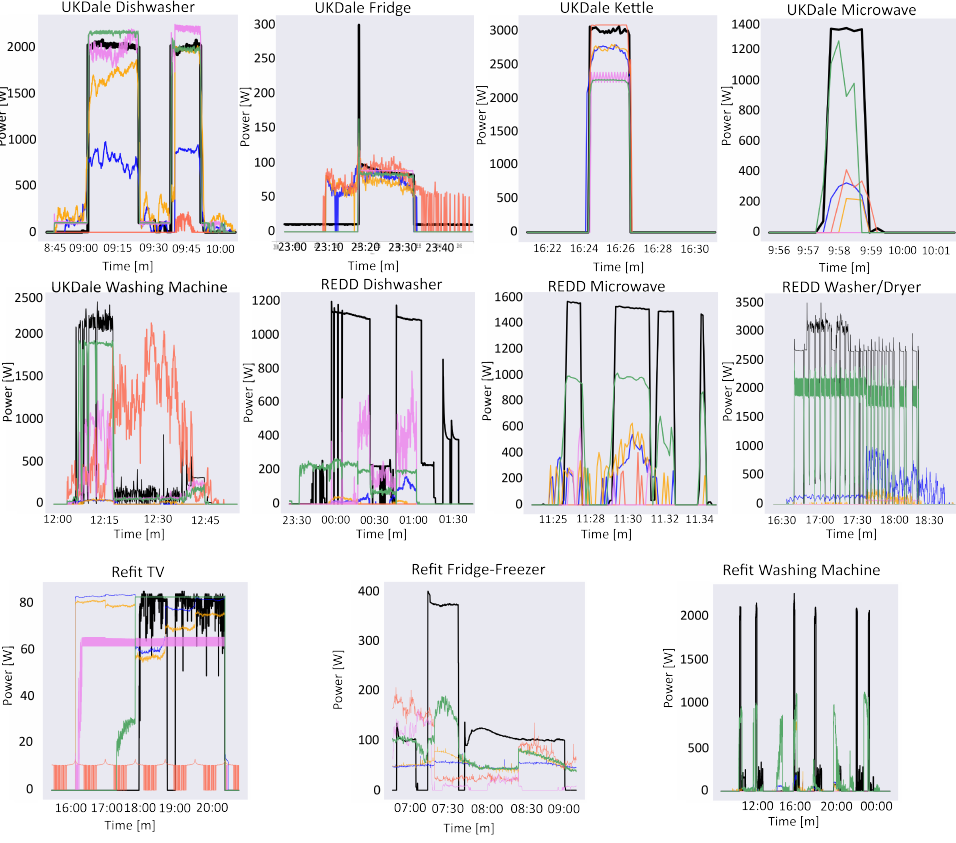
Figure 4. Comparison between ground truth appliance consumption signal and comparative model outputs for all examined